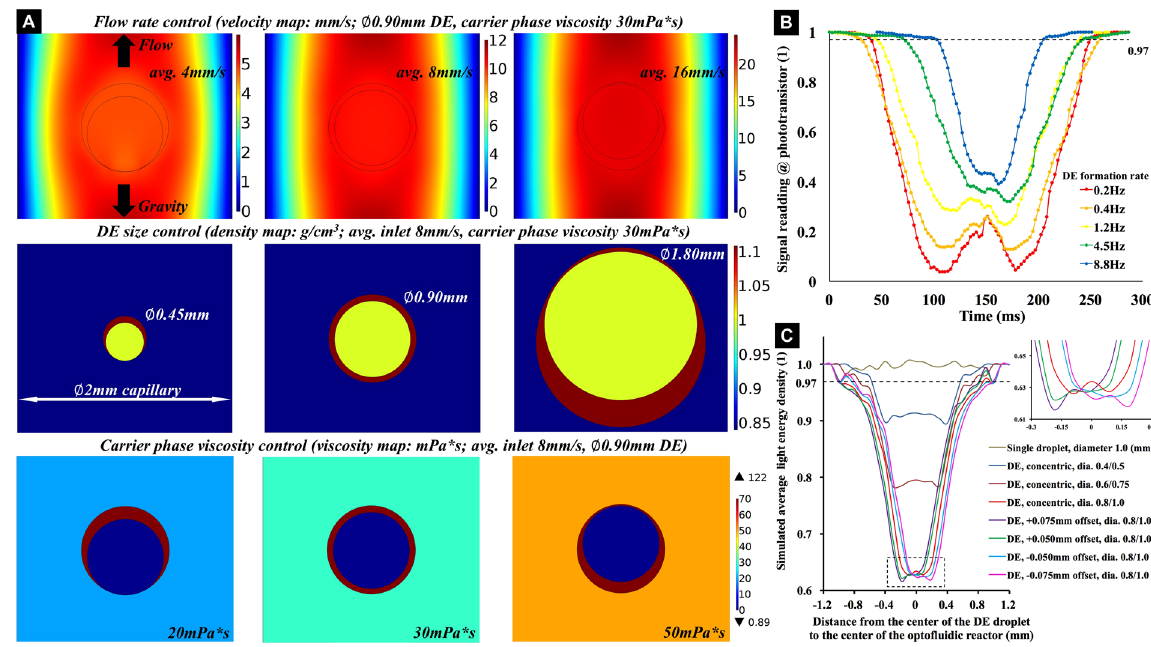
Figure 2. On-flow DE droplet centralization, detection and shape analysis. ( A ) Simulated images show that the equilibrium states of DE droplet shapes when the droplets are rising in 2 mm wide tubular capillary, with the presence of gravity. The states are influenced by the average flow velocity, the size of DE droplet and carrier phase velocity. While a ϕ 0.90 mm DE droplet flows in an avg. 8 mm/s laminar flow, carried by 30 mPa * s continuous phase, the droplet attains a spherical and concentric form. ( B ) The charts show the phototransistor detection signal readings of the rising DE droplets, which were formed at different rates. The presence of DE droplets diverged the red laser light, resulting in decreased incident irradiance on the phototransistor, compared to the nominal value obtained with a mineral oil (only) carrier phase flow. The signal shapes change from “W” to “V”, indicating different beam transmission situations. This was due to lensing effects from morphologies variation of DE droplets, when passing across the detection beam. (C ) Simulated on-flow droplet detection signal, predicting that concentric DE droplets produce a “W” shaped photo-detector signal, non-concentric DE droplets produce a “V” shaped photo-detector signal, the magnitude of which depends upon the size of the DE droplet and the water droplet position. Highlighted section of upper image is shown in lower image in more